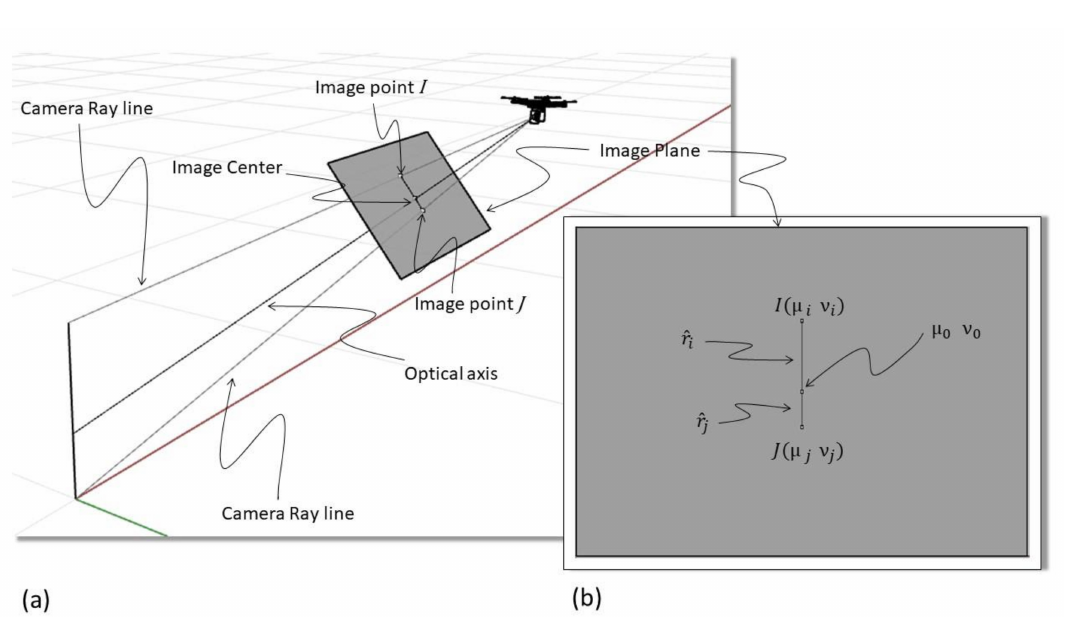
Figure 4. Graphical representation of a lightweight unmanned aerial vehicle (UAV) pointing to a vertical pole ( a ) with a roll angle equal to zero. In ( b ) the image plane is represented in orthogonal view (as it would appear on a screen) (source: personal collection). Please note that ( a ) is a perspective view, please refer to ( b ) to visualize the image plane without